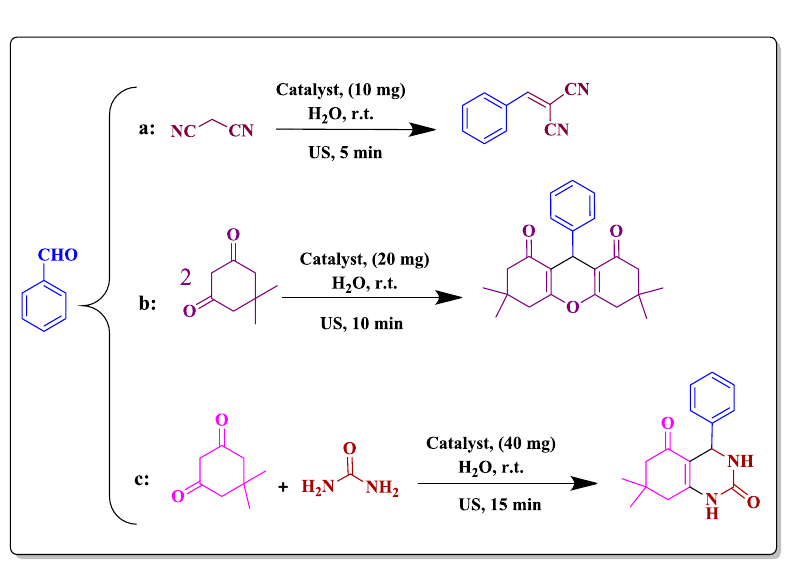
Figure 2. Model reaction of ( a ) Knoevenagel condensation, ( b ) synthesis of xanthan and ( c )